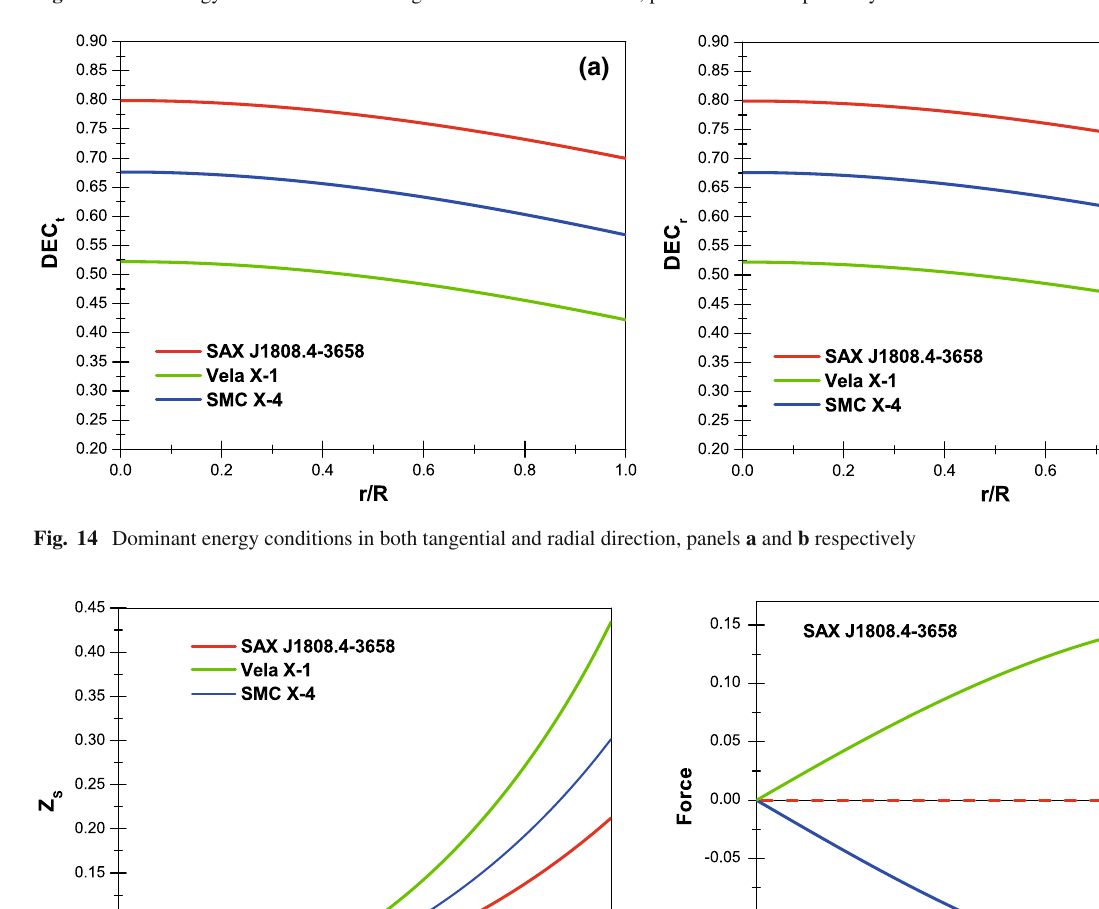
Fig. 13 Weak energy conditions in both tangential and radial direction, panels a and b respectively